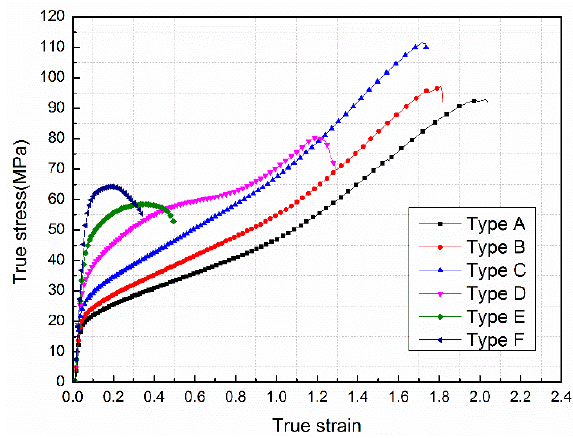
Figure Figure 6. The true stress-strain curves for the six types of Al-Ni-PTFE specimens under quasi-static compression.